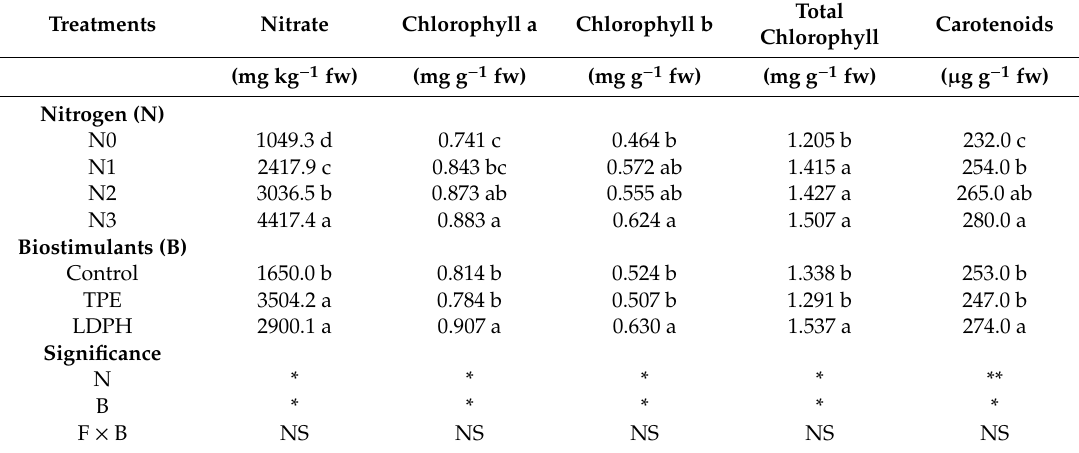
Table 5. Baby rocket leaf plants nitrate, chlorophyll, and carotenoid content as mean value of the three harvests, in relation to N fertilization rates (N0 = 0, N1 = 60, N2 = 80, and N3 = 100 kg ha − 1 ) and biostimulant application (Control, tropical plant extract (TPE): Auxym and legume-derived protein hydrolysate (LDPH):